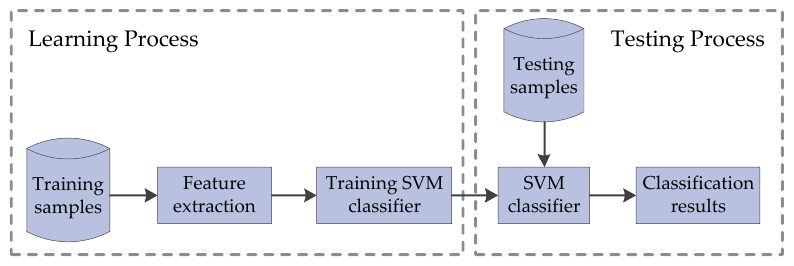
Figure 8. Training and testing process of SVM.